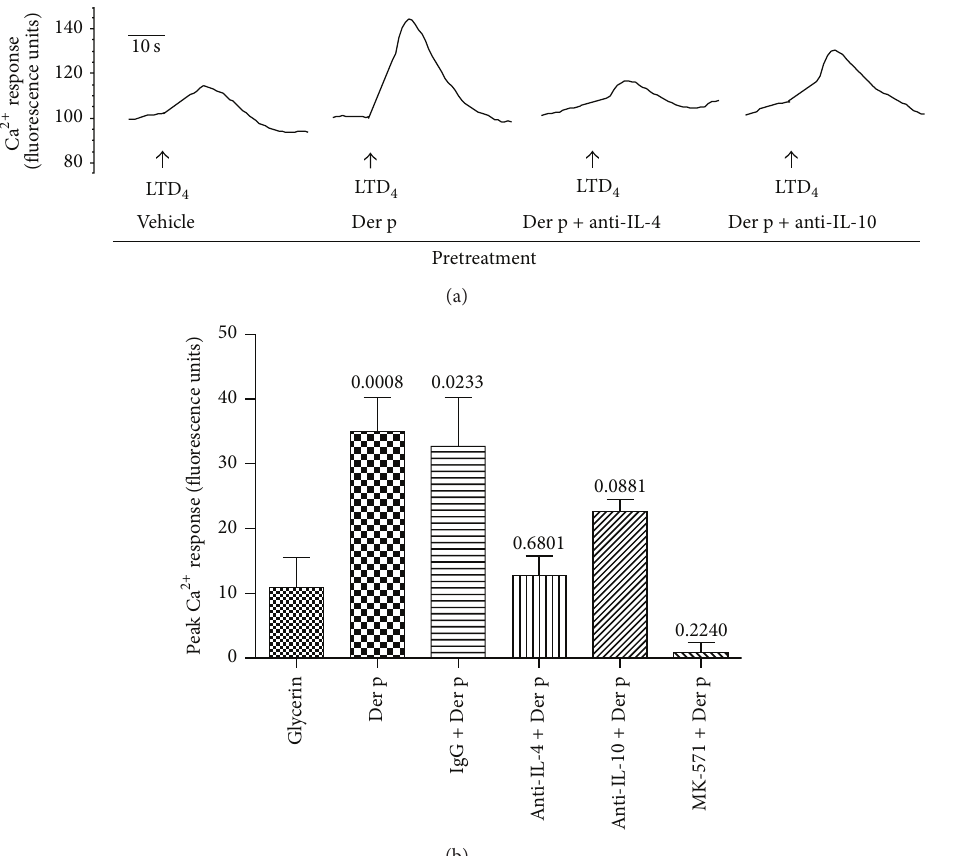
Figure 4: Functional analysis of increased CysLT 1 expression on T cells. The biological significance of the enhanced CysLT 1 receptor expression on T cells was assessed by measuring intracellular calcium flux in response to LTD 4 . PBMC from HDM-allergic (HDMA) individuals were exposed for 72 h to Der p in the presence or absence of neutralizing Abs to IL-4 or IL-10 or of the CysLT 1 receptor antagonist MK571. Cells were then labeled with anti-CD3 and anti-CD4 Ab and loaded with Fluo4-AM for the calcium mobilization assay on a FACSCalibur flow cytometer. (a) Raw data representative of 4 separate experiments. (b) Compiled data of peak calcium responses. 𝑛 = 3 ; 𝑃 values indicated above histograms, with respect to the